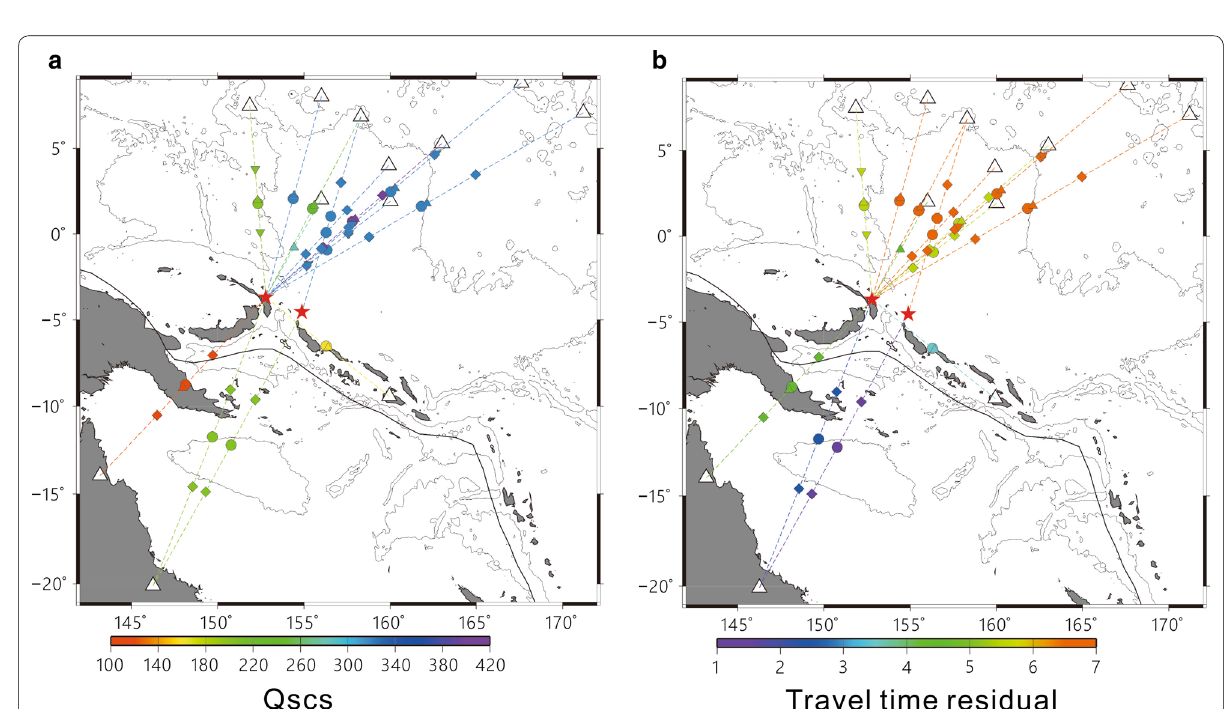
Fig. 4 Q ScS values ( a ) and travel time residuals ( b ) of multiple ScS waves estimated in the present study. Surface bounce points of ScS2, ScS3, sScS, sScS2, and sScS3 waves are denoted by circles, diamonds, crosses, solid triangles, and inverted triangles, respectively. The dotted lines are great circles from event to stations (projection of ScS wave paths on the surface). The colors of the symbols and the dotted curves represent Q ScS values in ( a ) and travel time residuals in ( b ). Stars and open triangles are epicenters and stations,